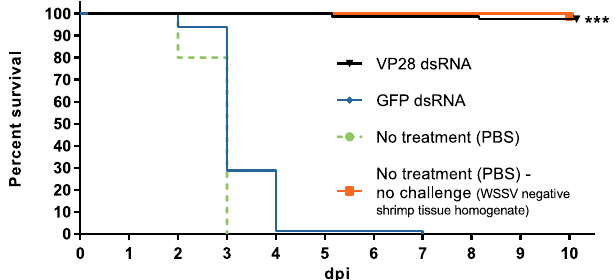
Figure 2. Efficacy of IM dsRNA treatment measured by survival percentage after IM WSSV challenge. 48 hours post treatment administration, 100 shrimp in 5 parallel tanks per treatment group were IM challenged with a WSSV dose equivalent to approximately 1000 WSSV genome copies per shrimp. For each group, 4 tanks holding 20 shrimp each were monitored through 10 dpi to assess the efficacy of VP28 dsRNA treatment, and relative survival from these shrimp is here presented in a Kaplan-Meier plot. Log-rank (Mantel-Cox) test with Bonferroni correction ( α = 0.05/21) was performed on VP28 dsRNA treatment group in comparison to the GFP dsRNA treatment group (p <